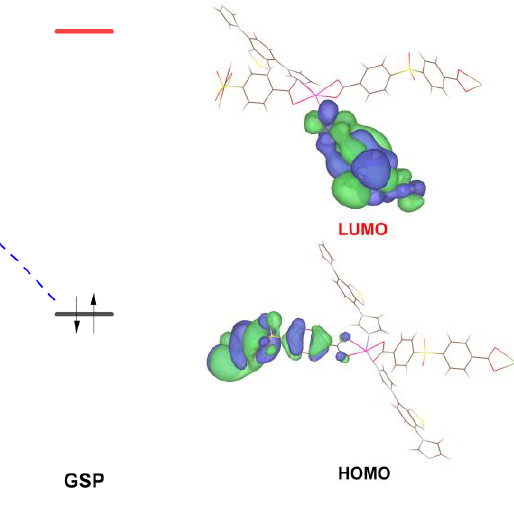
Figure S6. Luminescence spectra of ethanol suspension of MOF 1 with and without cottonseed oil; Figure S7. Recycling experiment of gossypol detection with MOF 1 . Relative integral intensities are shown. The relative quenching values (I 0 − I)/I are 0.14 (cycle 1), 0.14 (cycle 2) and 0.12 (cycle 3); Figure S8. Calculated and experimental PXRD patterns for MOF 1 after the sensing experiment; Figure S9. PXRD pattern of GSP-soaked MOF 1 and calculated pattern from SCXRD data; Figure S10. Le-Bail fitting of GSP-soaked MOF 1 ; Figure S11. Photoluminescence decay curve for solid-state MOF 1; Figure S12. Photoluminescence decay curve for MOF 1 blank ethanol suspension; Figure = 0.01 mM); Figure S14. UV-Vis spectra of gossypol solutions in 10 −6 and 10 −8 M ethanol solutions; Figure S15. UV-Vis spectra of MOF 1 ethanol suspension upon addition of different concentrations